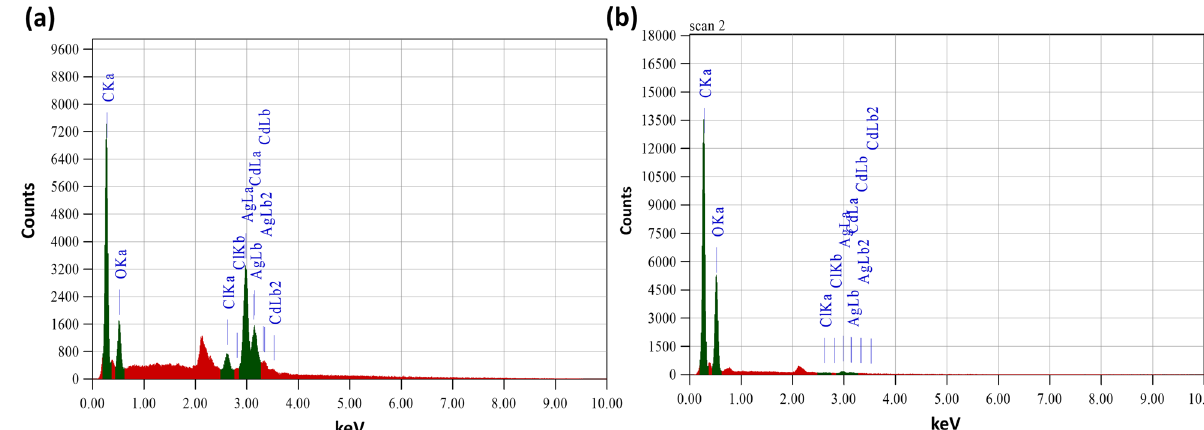
Figure 3. Elemental analysis of nanomaterials using energy dispersive x-ray technique. ( a ) silver nanoparticles (AgNPs) and ( b ) nanocomposite system